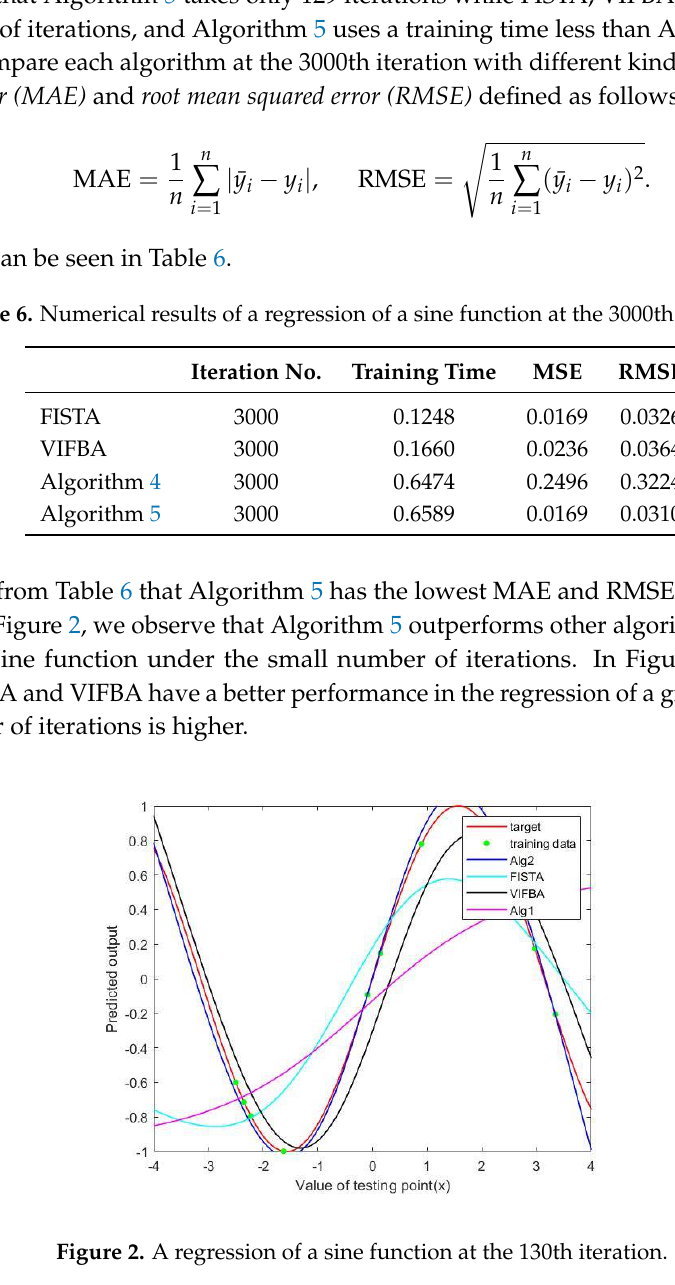
Figure 2. A regression of a sine function at the 130th